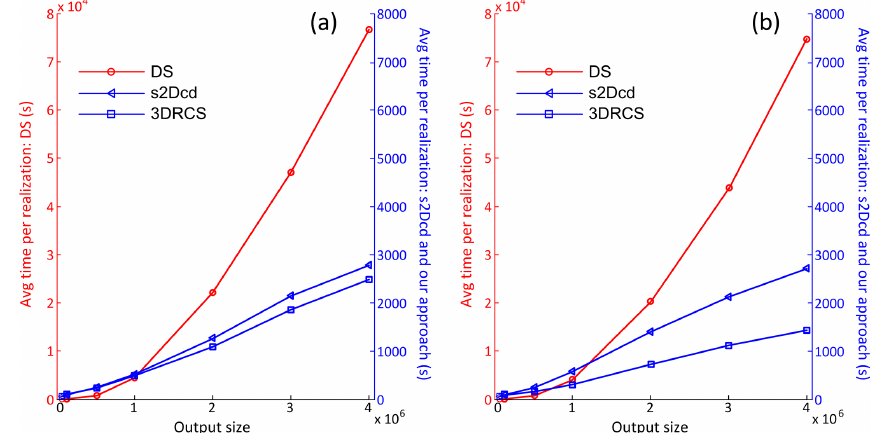
Figure 14. Comparison of computational performance between DS, s2Dcd and 3DRCS when increasing the size of output grid: (a) two cross sections and (b) four cross sections in each direction. Note that different time axes are used in the two subplots, and four processors are used for DS-based reconstruction and s2Dcd but only one for 3DRCS.